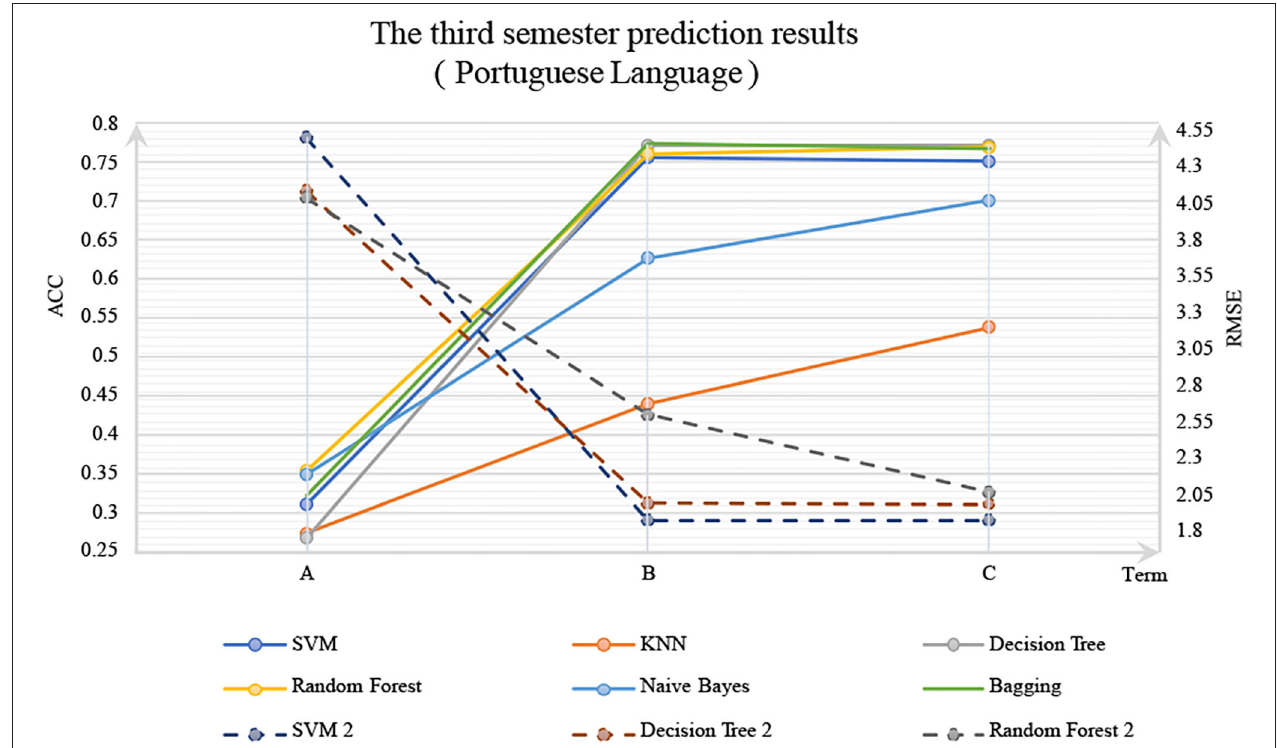
FIGURE 2 | Portuguese